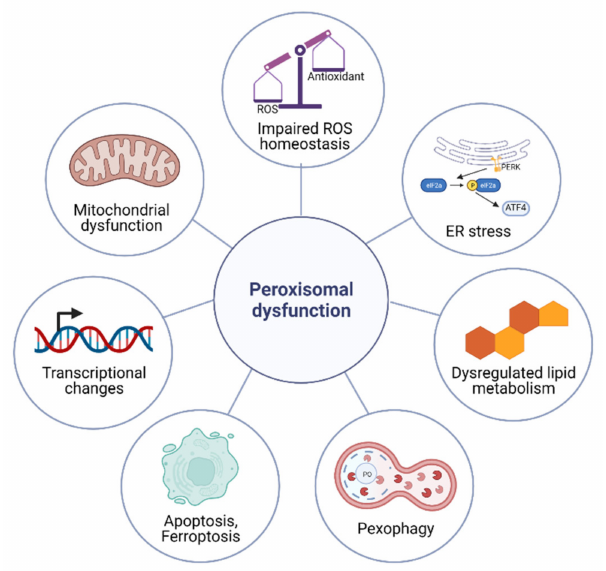
Figure 1. Cellular responses to peroxisomal dysfunction. Impaired peroxisomal function elicits cellu- lar responses such as the impaired ROS homeostasis, dysregulated lipid metabolism, mitochondrial dysfunction, altered gene expression, pexophagy, elevated ER stress, and